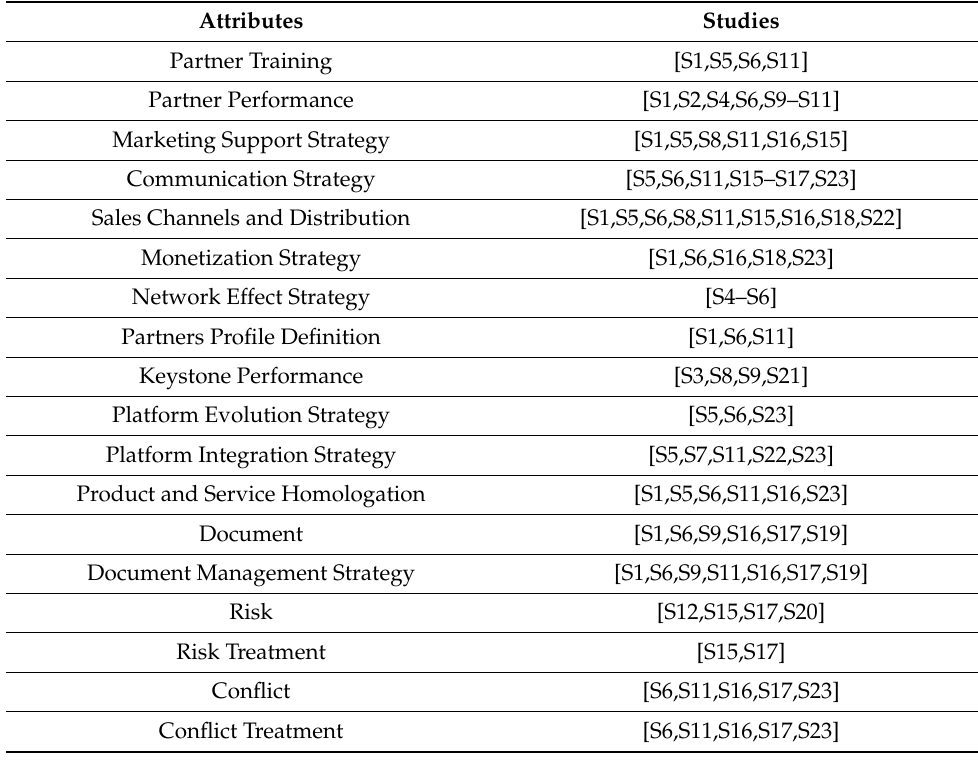
Table 4. Attributes of the proposed partnership meta-model and studies of